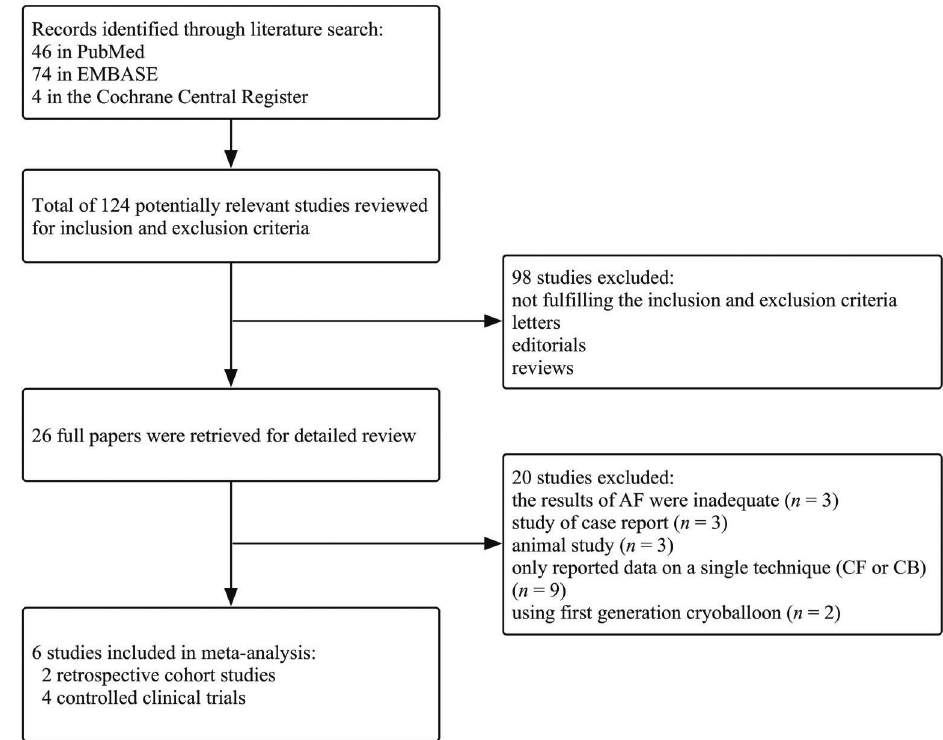
Figure 1. Flow diagram of the stages of the literature search. AF: atrial fi brillation; CF: contact force; CB: cryoballoon.